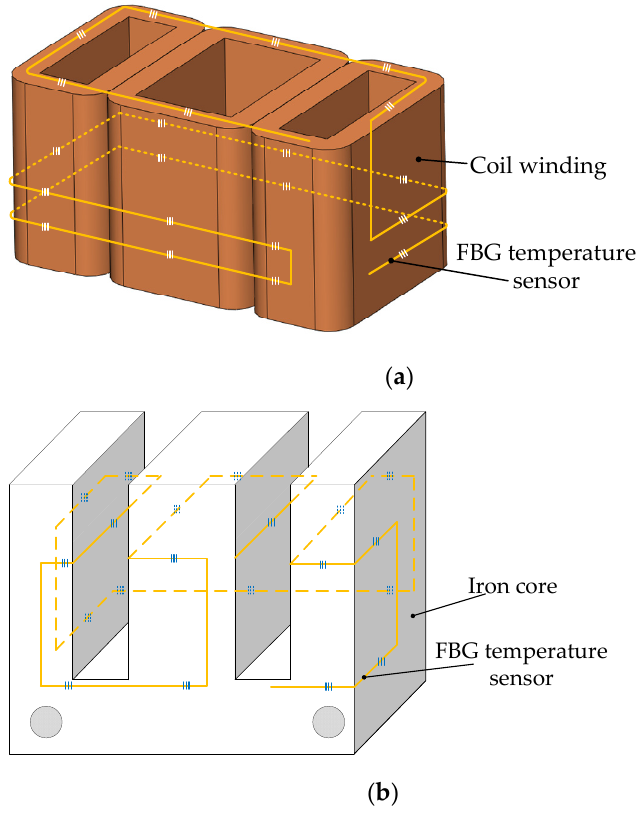
Figure 12. Arrangement of electromagnet temperature measuring points. ( a ) Arrangement of FBG measuring points on coil winding; ( b ) arrangement of FBG measuring points on electromagnet core.